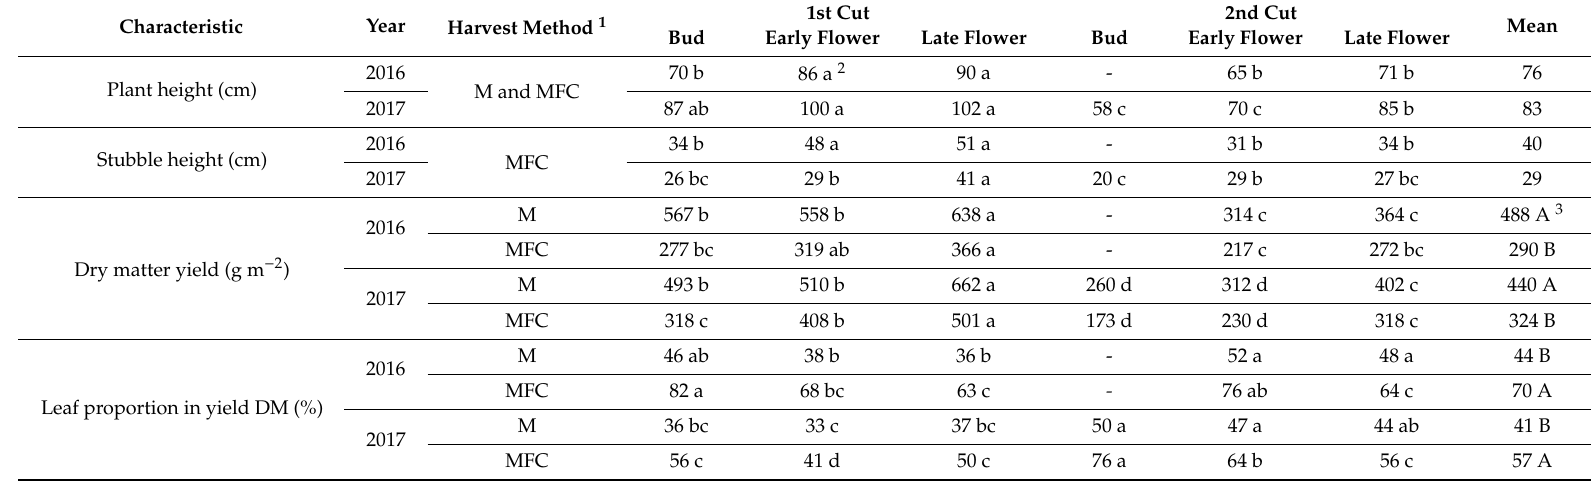
Leaf proportion in yield DM